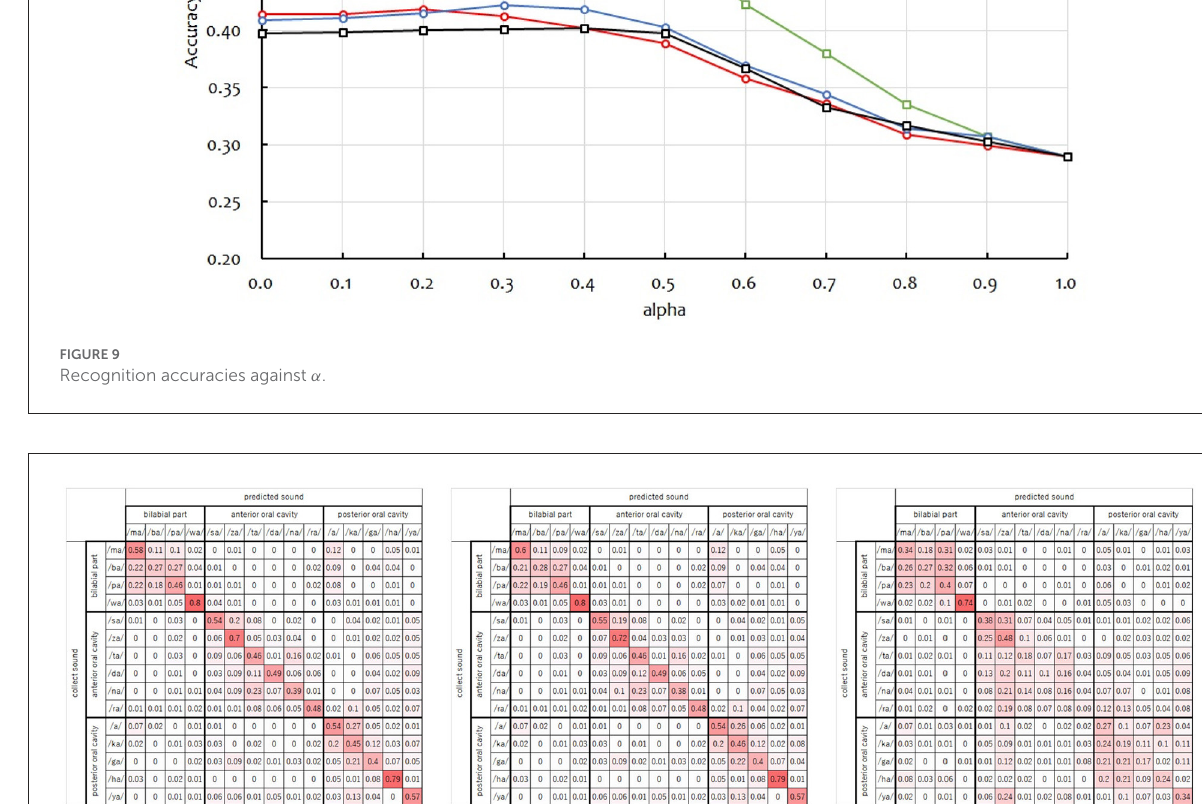
accuracy of 0.528 was obtained at 60 fps. Humans